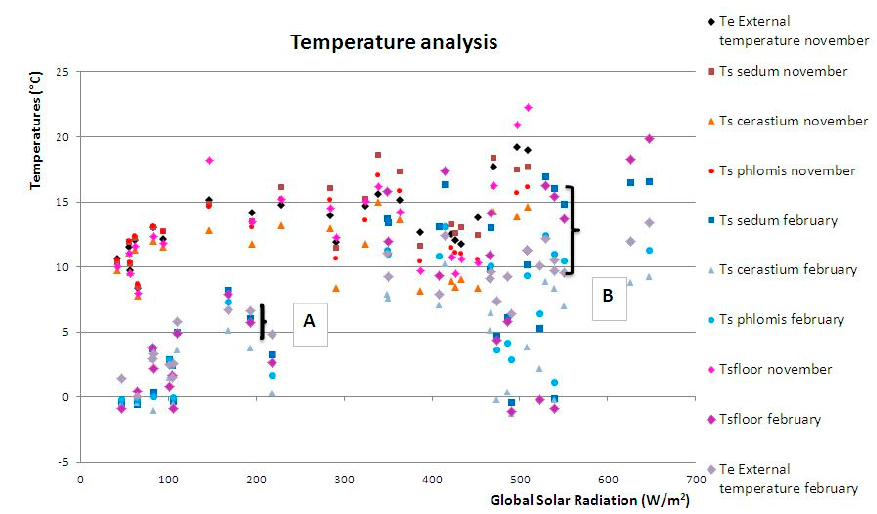
Figure 10. T s analysis as a function of the global solar radiation.